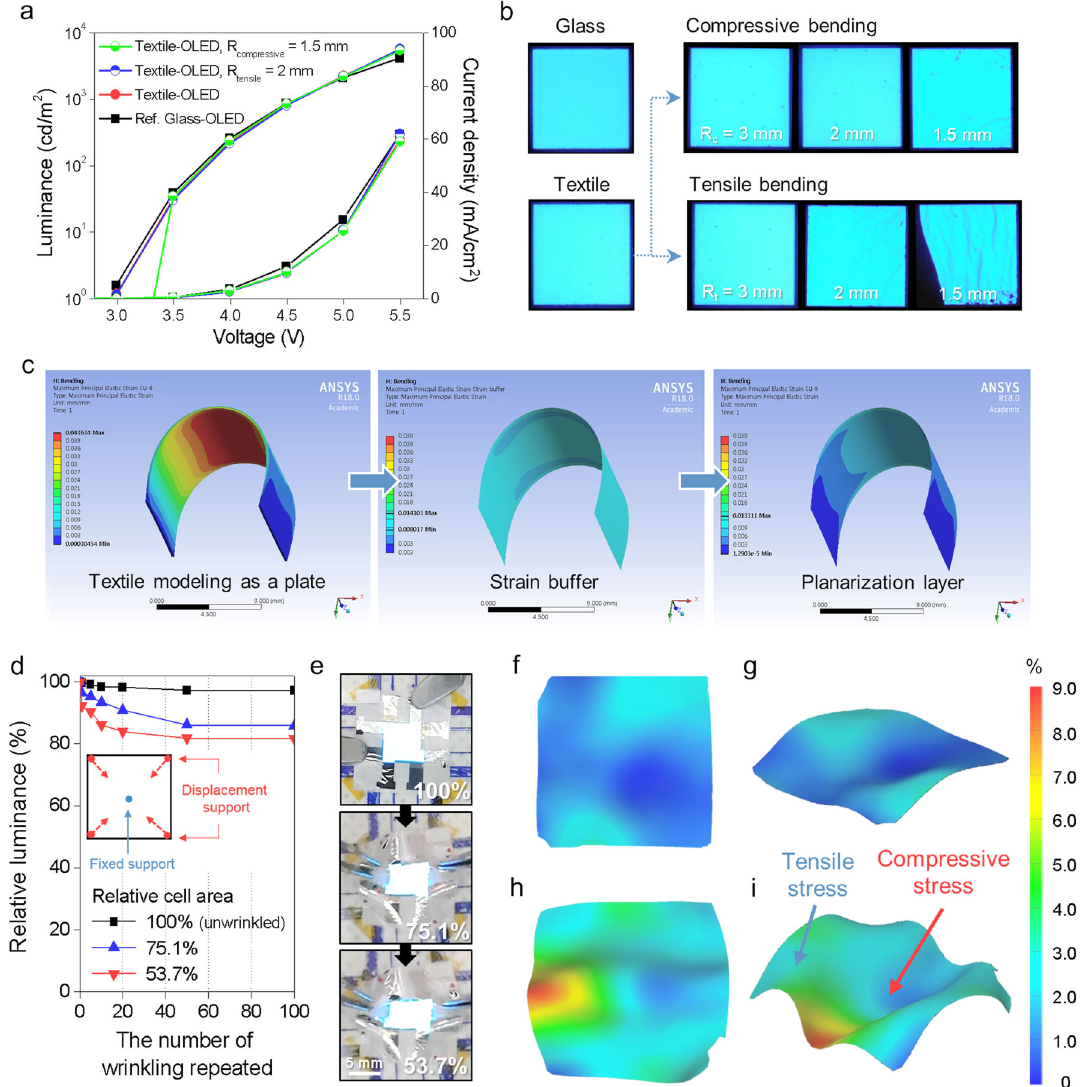
Fig. 3 Bending and wrinkling characteristics of the textile-OLEDs. a Repetitive bending test of the textile-OLEDs in the tensile and compressive directions, the number of bendings: 1000 (reference: OLED fabricated on the glass substrate). b The cell images of the textile- OLEDs after bending. c Strain analyses of each layer within the bent textile platform using FEM mechanical simulation. d Repetitive wrinkling test of the textile-OLEDs, the initial luminance: 1000 nit (inset: schematic diagram of how the wrinkling test was conducted). e The cell images of the textile-OLEDs after wrinkling. f – i Strain analyses of the wrinkled textile-OLEDs using DIC, the relative cell area of 75.1% in the top view and the arbitrary view, the relative cell area of 53.7% in the top view and the arbitrary